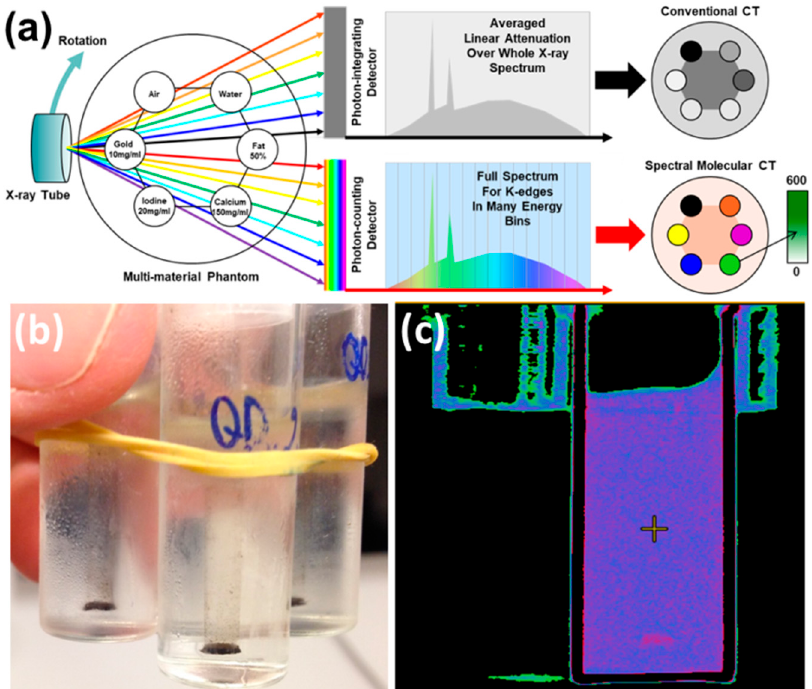
Figure 5. ( a ) Schematic of a spectral CT with photon-counting detectors (PCDs) compared with a conventional CT. ( b ) A dispersion of 160 μ g PAA-stabilized Lu-NPhs’ (front image; 18% grafting density) embedded onto a 1 × 1 × 2.5 cm 3 gelatin, tumor-mimic phantom, imitating desired material accumulation into tumors. ( c ) CT scan of the front image phantom from b in our spectral CT scanner showing high material separability. Black: vial with nothing loaded (air); Pink: hydrogel media; Intense pink: contrast agent.